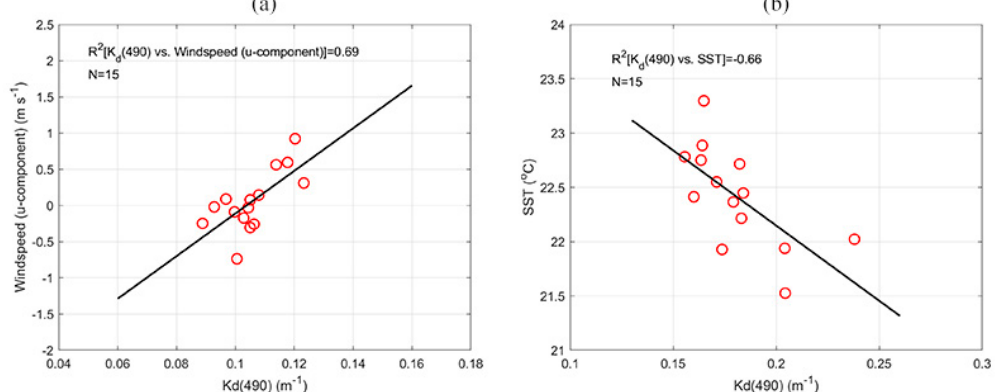
Figure 10. ( a ) Scatterplots of average K d (490) and wind speed ( u -component) in summer, ( b ) scatterplots of average K d (490) and sea surface temperature (SST) in winter.